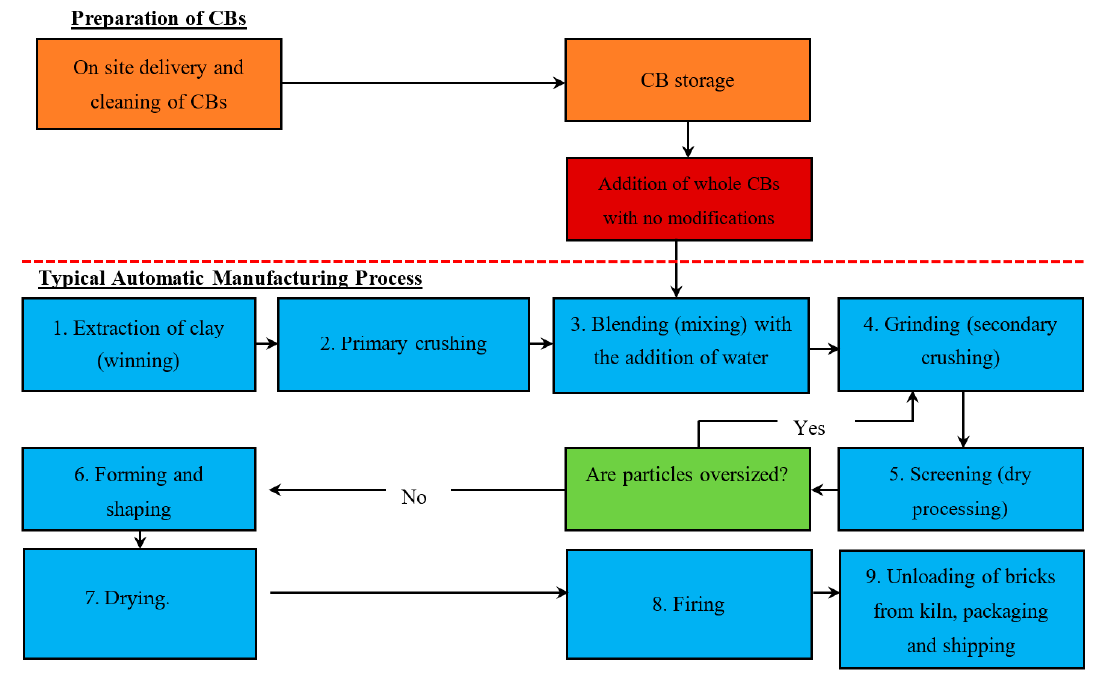
Figure 2. Method 1—The addition of whole cigarette butts (CBs) into the Automatic Manufacturing Process.